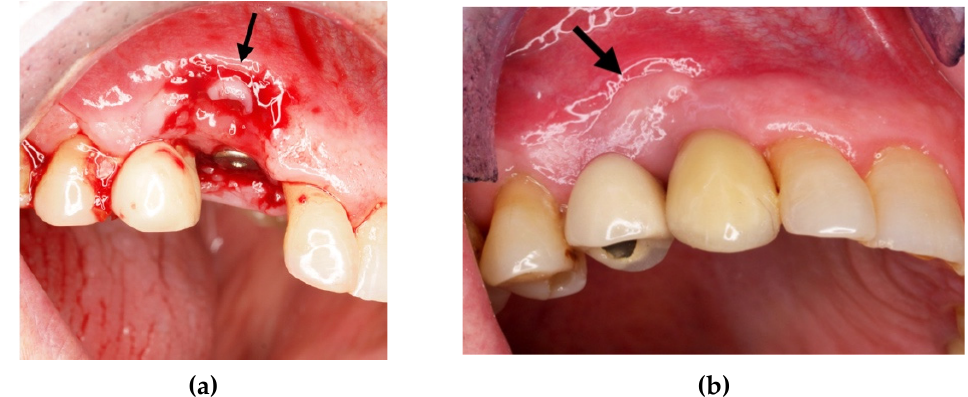
Figure 9. ( a ) Flap of keratinized mucosa indicated by the arrow; ( b ) finalization with a prosthetic crown.